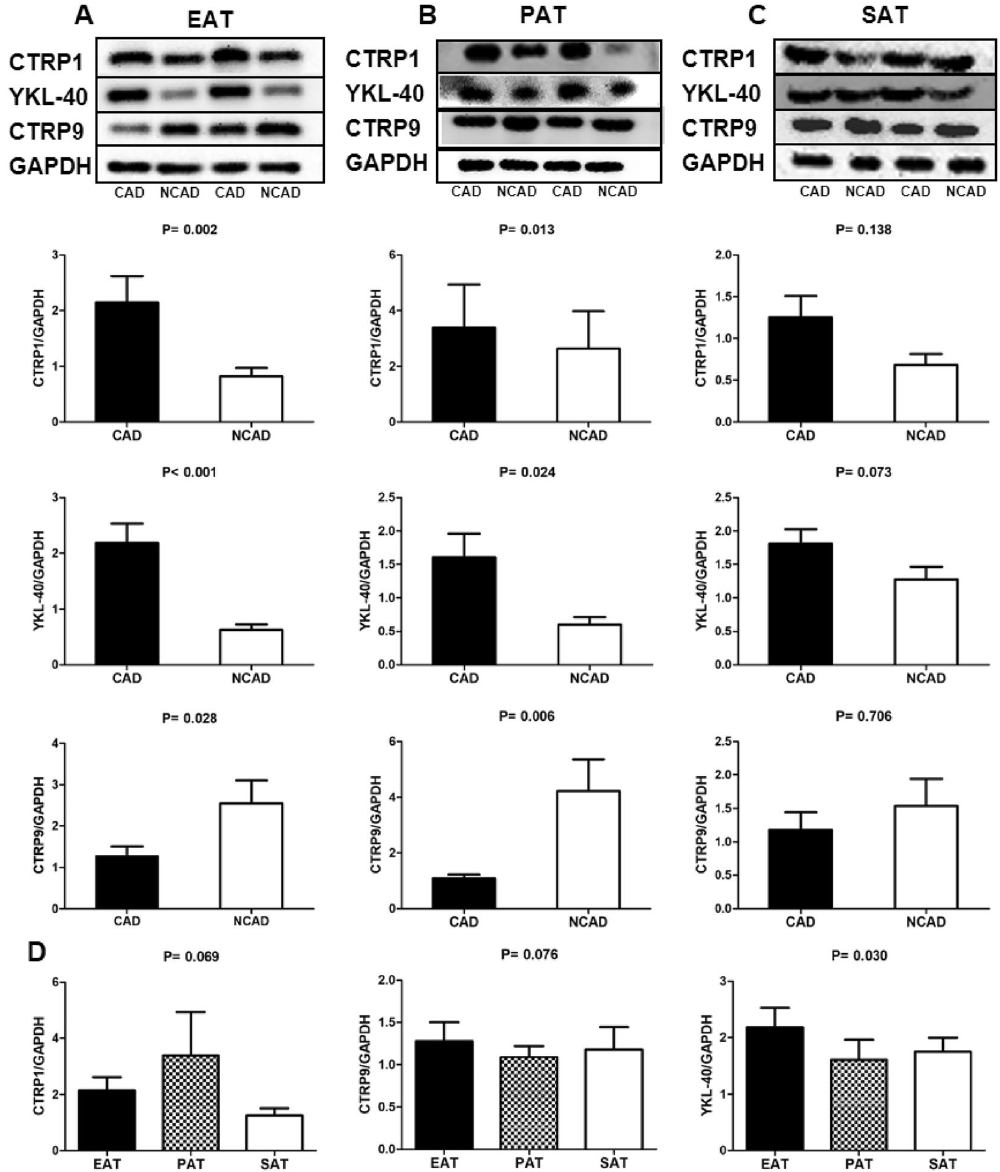
Figure 2. Inflammatory cytoadipokines protein expression levels in adipose tissues in CAD (n = 26)and NCAD (n = 20) groups. ( A ) Representative bands and quantitative analyses of CTRP1, YKL-40, CTRP9 protein expression in EAT. ( B ) Representative bands and quantitative analyses of CTRP1, YKL-40, CTRP9 protein expression in PAT. ( C ) Representative bands and quantitative analyses of CTRP1, YKL-40, CTRP9 protein expression in SAT. ( D ) Quantitative analyses among EAT, PAT, SAT of CTRP1, YKL-40, CTRP9 protein expression in CAD group (n = 26). The Mann–Whitney U test was used to compare the relationship between the CAD and NCAD groups. The Kruskal–Wallis H test was used for the comparison among the three groups, and the multiple comparison between the groups was used “all pairwise”, the test level was adjusted to P = 0.0083. Source data was the average relative density of immunoblot bands of all adipose tissue samples in CAD and NCAD patients. The cropped inserts show representative immunoblot examples for CTRP1, CTRP9, YKL- 40, GAPDH of 3 adipose tissue. The original immunoblots are available in Supplementary Figs. S1–S12; P values resulting from comparison of CAD group and NCAD group means of concentration values through the Wilcoxon test are written above each boxplot pair. During the test of Western blotting, the blots were cut prior to hybridization with the